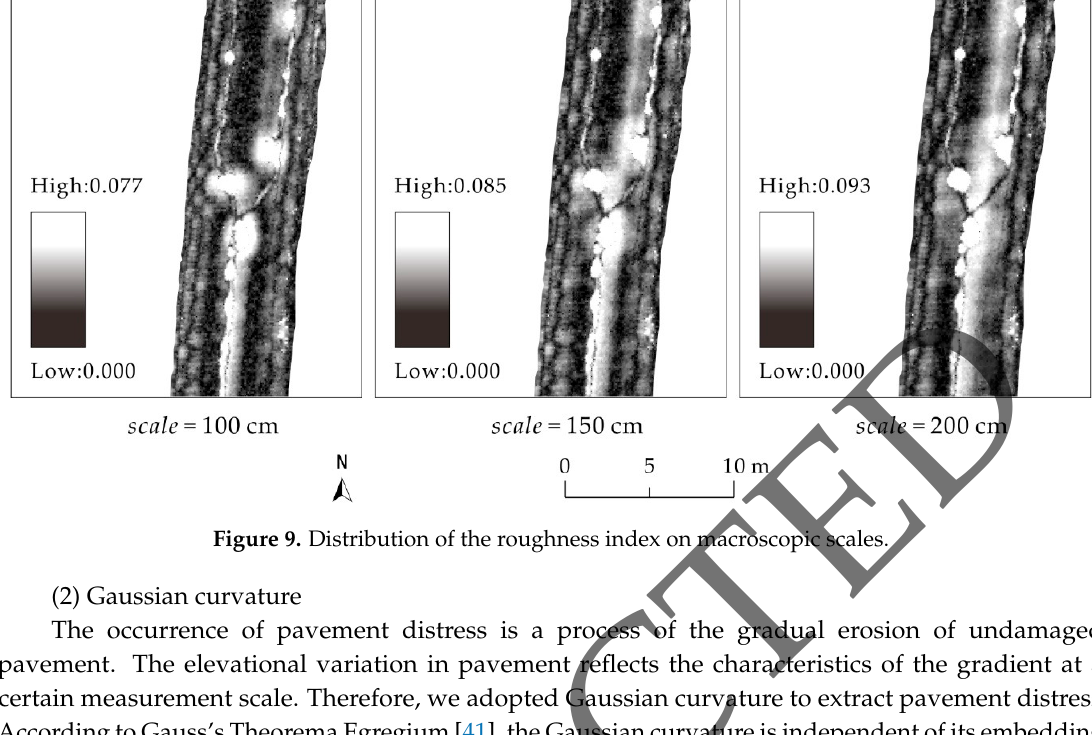
Figure 9. Distribution of the roughness index on macroscopic scales.